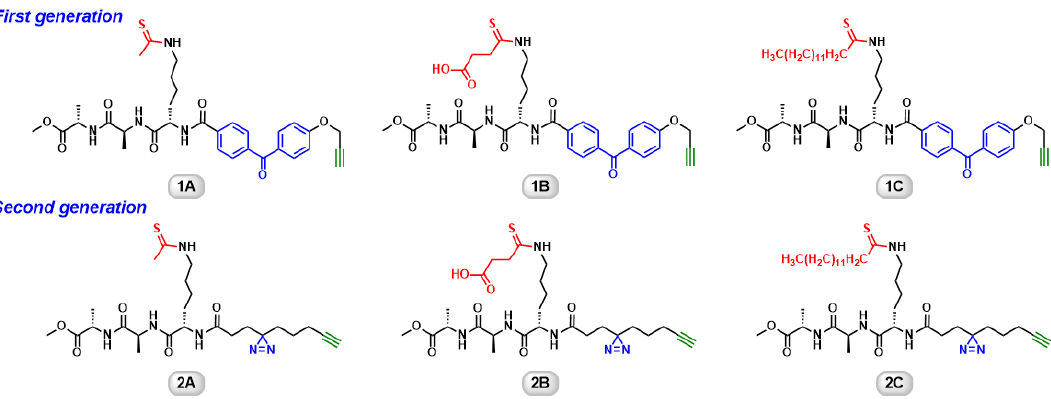
Figure 1. Chemical structures of activity-based chemical